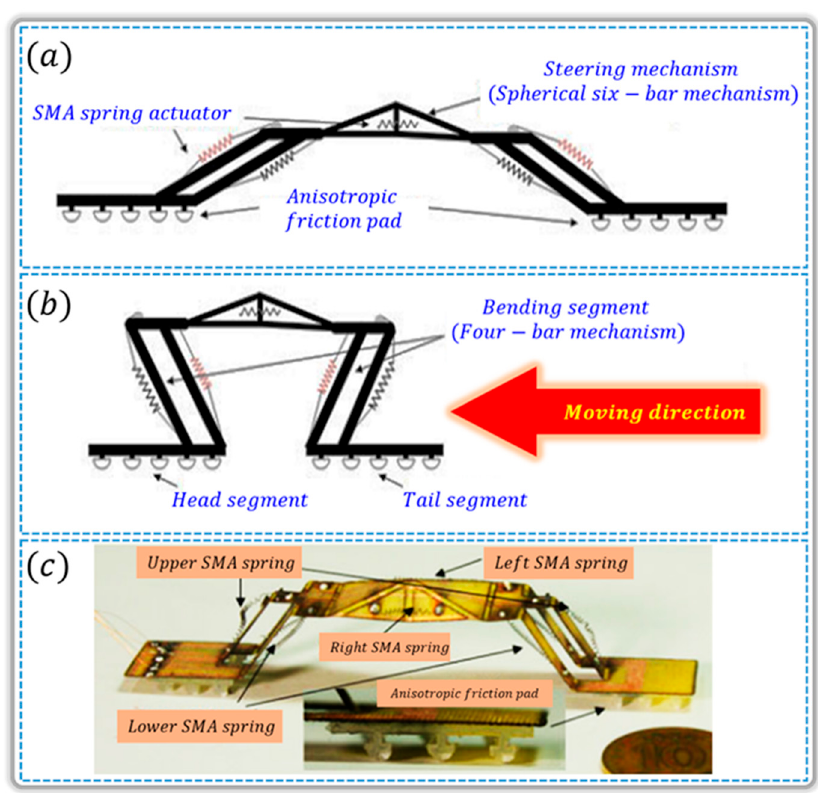
Figure 10. ( a , b ) Schematic design of the Omegabot developed by Koh et al. [104], ( c ) final prototype of an Omegabot. Note: red coils show the activated actuator. Adapted with permission from [104], IEEE, 2013.